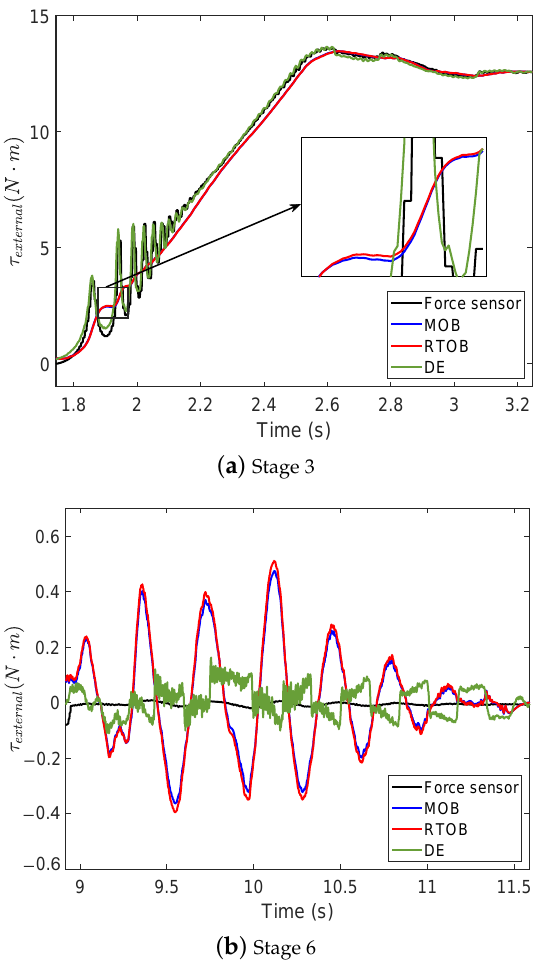
Figure 17. The result of external torque estimation during physical